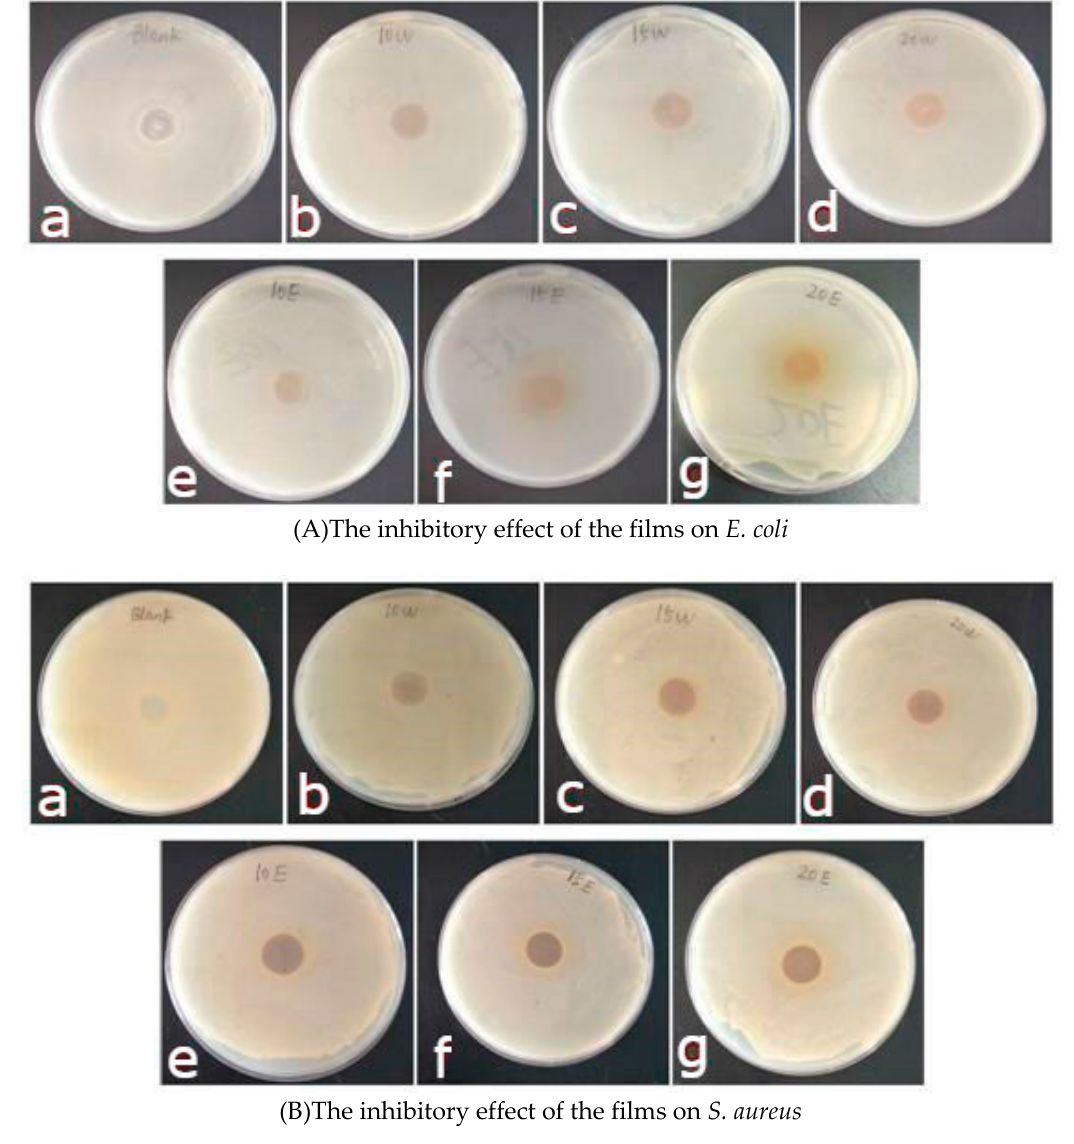
Figure 6. The antibacterial activity of the different films against E. coli ( A ) and S. aureus ( B ). ( a : SAF, b : 10%WEF, c : 15%WEF, d : 20%WEF, e : 10%EEF, f : 15%EEF, g : 20%EEF).